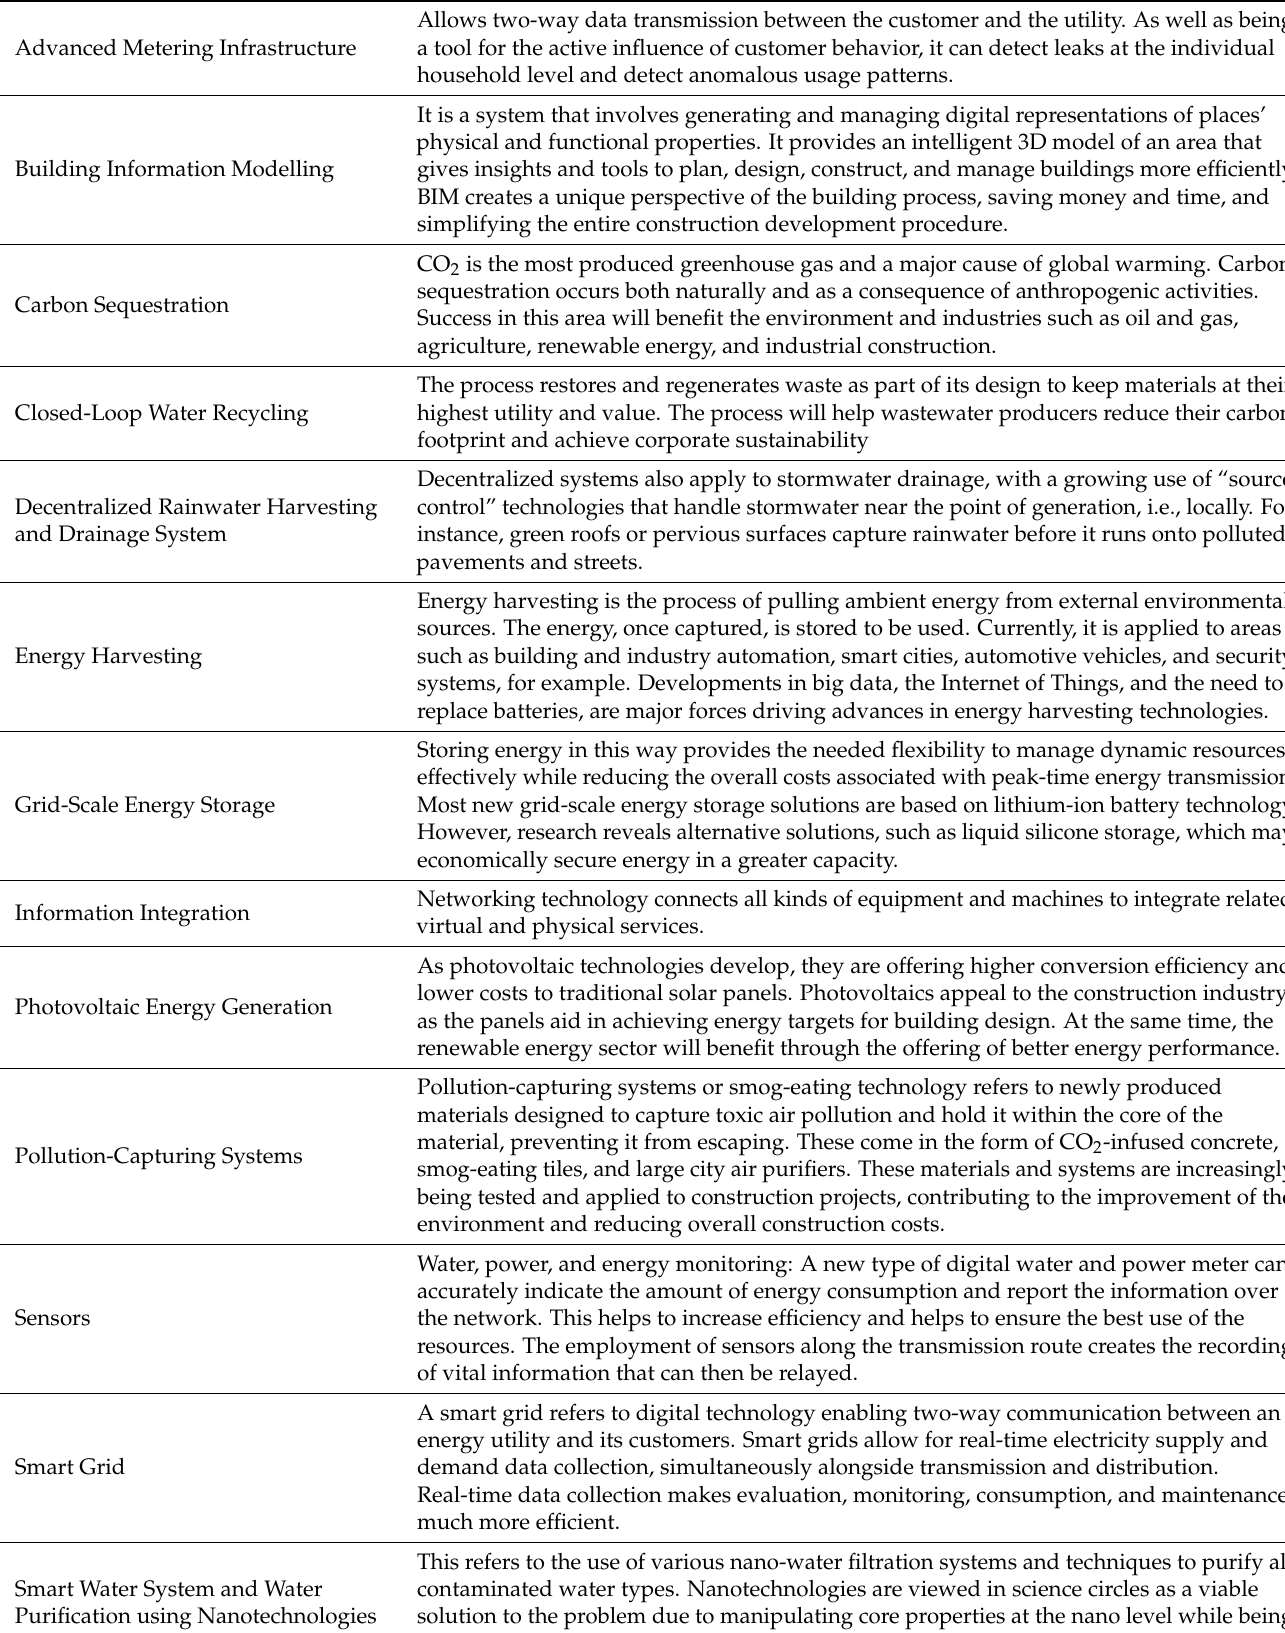
Table 8. The selected technologies with a brief